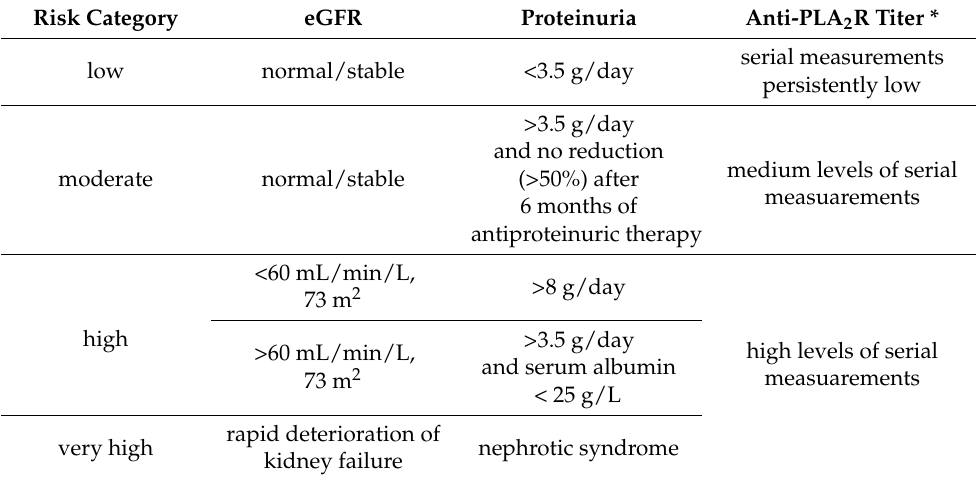
Table 3. Risk evaluation of disease progression